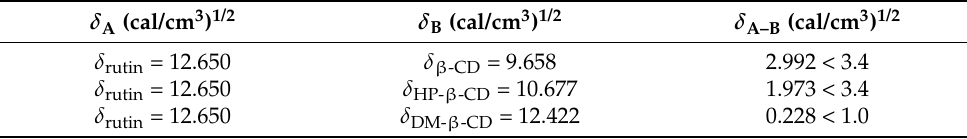
Table 3. Solubility parameters of β -CD, HP- β -CD, DM- β -CD and